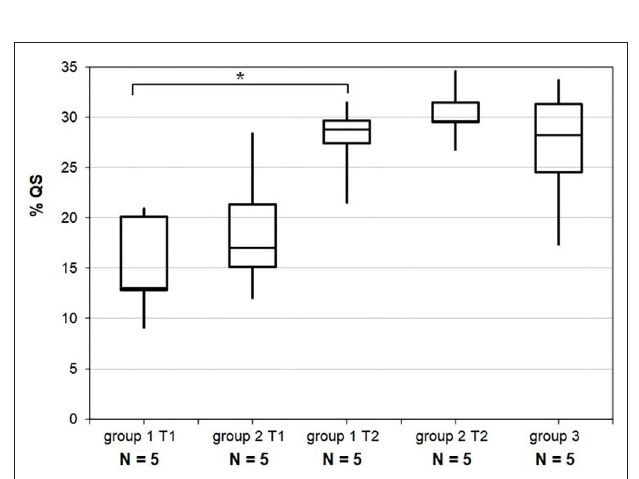
FIGURE 5 | Results for the percentage of time spent in quiet sleep. Distributions for each group and according to recording time T1 and T2. Horizontal lines grouping a pair of boxes denote statistically significant differences (* p < 0.05) in a Mann-Whitney u -test. % QS, percentage of quiet sleep; GA, gestational age; PMA, post-menstrual age; T1, recording time 1; T2, recording time 2.